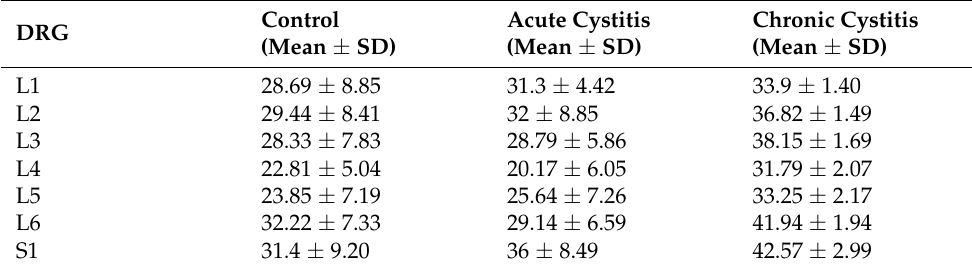
Table 1. Bladder afferent cells expressing p-CREB